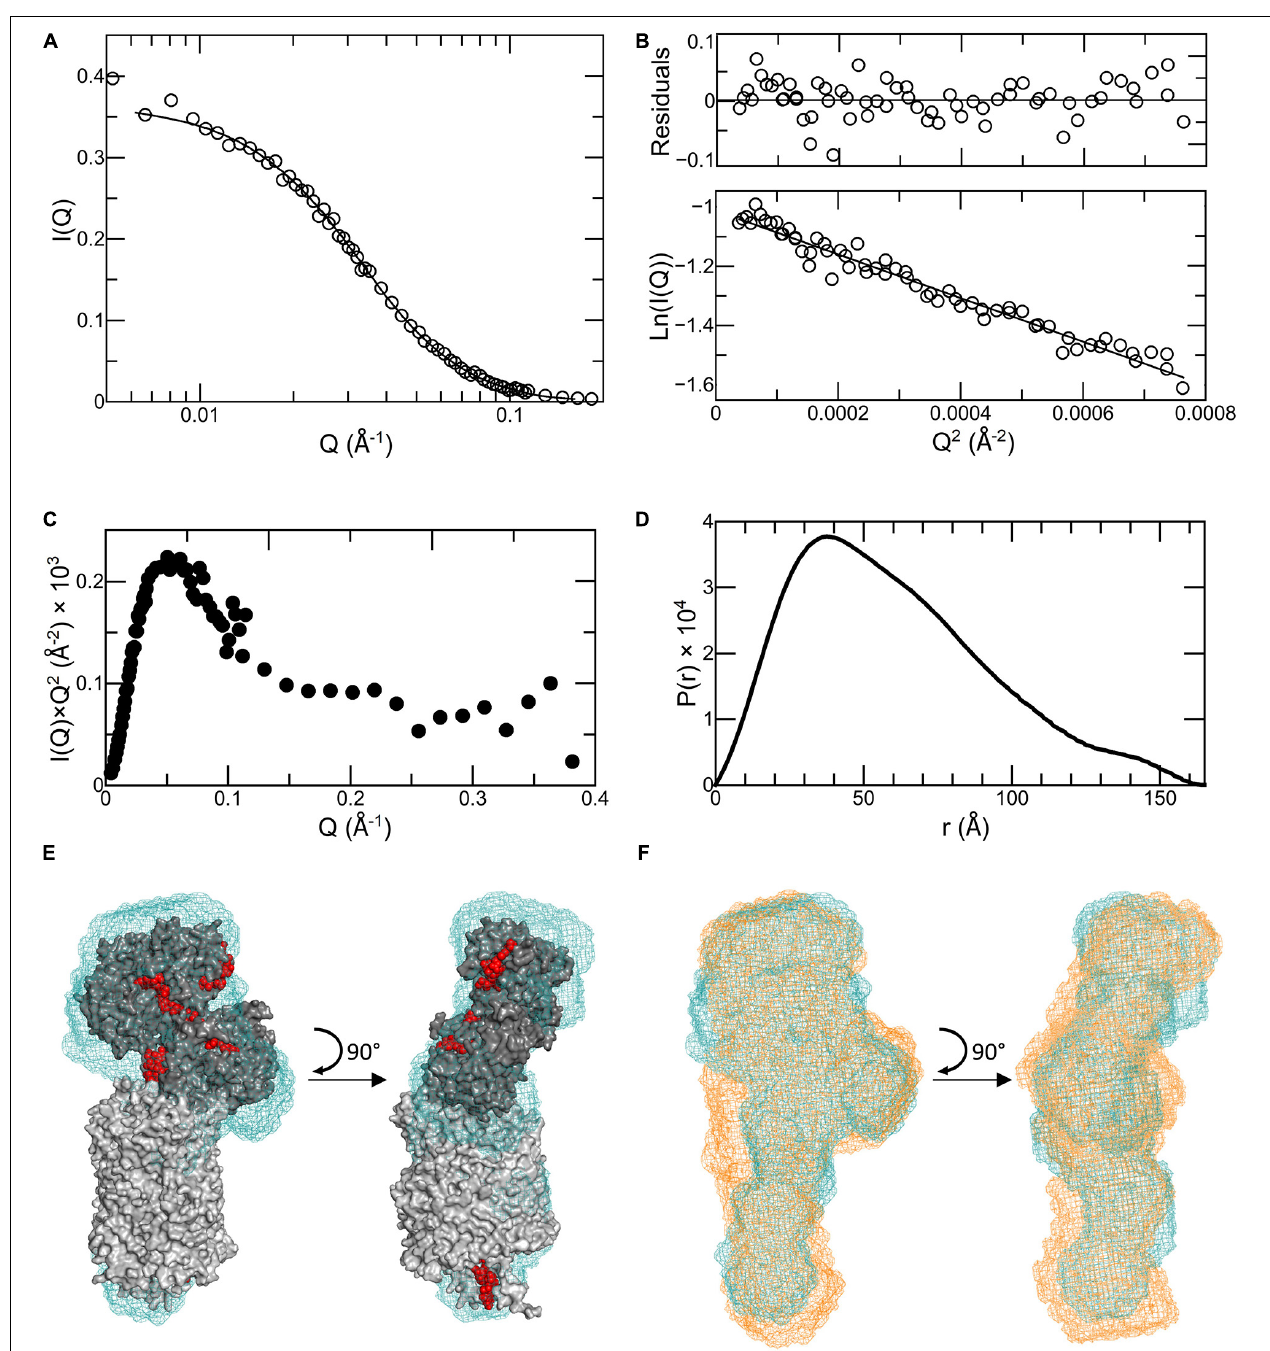
FIGURE 3 | Analysis of SANS data for Ru-MtrC:MtrAB. (A) Scattering data (truncated to Q = 0.161 Å − 1 ) shown as circles with the fit to the P ( r ) curve generated by GNOM shown as a line. (B) Guinier region of scattering curve, lower panel shows data as circles and a linear fit as a line. Upper panel shows residuals from fitting. (C) Kratky plot. (D) P ( r ) distance distribution curve. (E) Molecular envelope of Ru-MtrC:MtrAB (blue mesh) generated by DAMMIN aligned with the homology model of the MTR complex from S. oneidensis (gray with red hemes). (F) Molecular envelope of Ru-MtrC:MtrAB (blue mesh) aligned with that of the MTR complex (orange mesh). Source data for latter as reported in Edwards et al. (2018), see text for